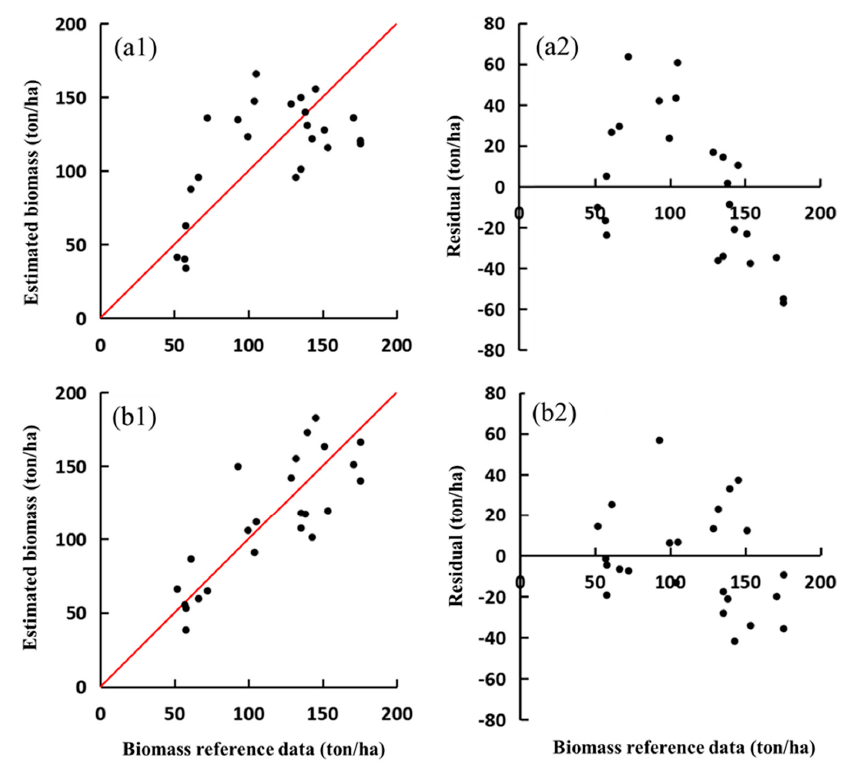
Figure 6. The scatterplots between biomass reference data and modeling results ( a1 , b1 ) and residuals ( a2 , b2 ) (note: a—modeling based on spectral signature, b—modeling based on the combination of spectral and forest canopy features; 1—relationship between biomass reference data and modeling results, 2—residuals).